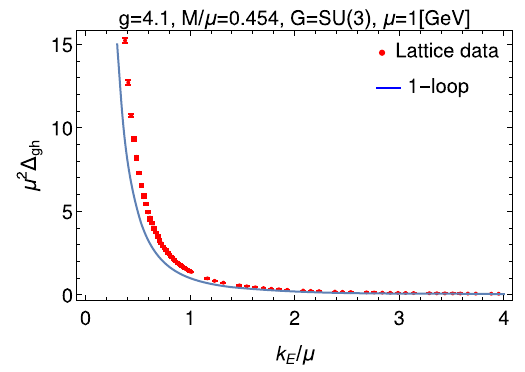
Fig. 6 The ghost propagator (cid:6) gh as a function of the Euclidean momentum k E in unit of μ . (red points) The numerical data for the ghost propagator of the SU(3) Yang–Mills theory on the lattice and (blue solid line) the plot of the analytical expression of the ghost prop- agator to one-loop order of the massive Yang–Mills model with two parameters g , M at the physical point